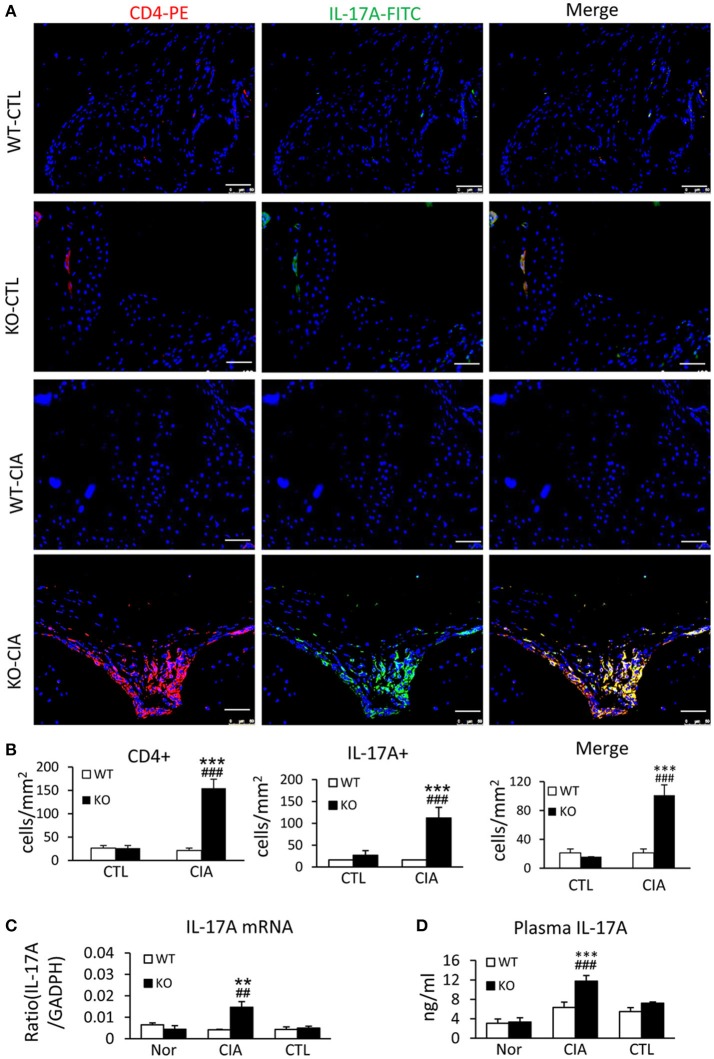
Smad7 deficiency largely enhances the Th17 response both systemically and locally in the synovial tissues of CIA in CD-1 mice. (A) Two-color immunofluorescence for detection of CD4+ IL-17A+ cells in the synovial tissues. (B) Quantitative analysis of CD4+, IL-17A+, and CD4+ IL-17A+ cells. (C) Real-time PCR analysis of IL-17A mRNA expression. (D) ELISA analysis of serum levels of IL-17A. Results show a marked Th17 response developed in Smad7-KO but not in Smad7-WT mice both systemically and locally in the joint tissues after disease induction at week 10. Data are expressed as mean ± S.E. for group of 8 mice. **p < 0.01, ***p < 0.001 vs. control group; ##p < 0.01, ###p < 0.001 vs. WT-CIA group. Scale bar, 50 μm.